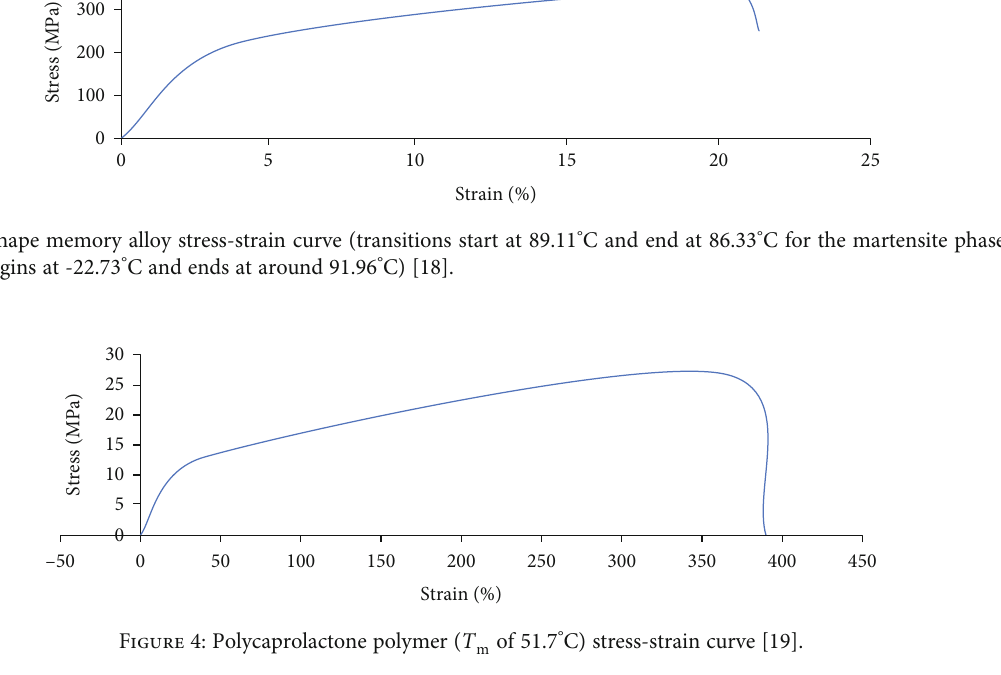
of 51.7 ° C) stress-strain curve m